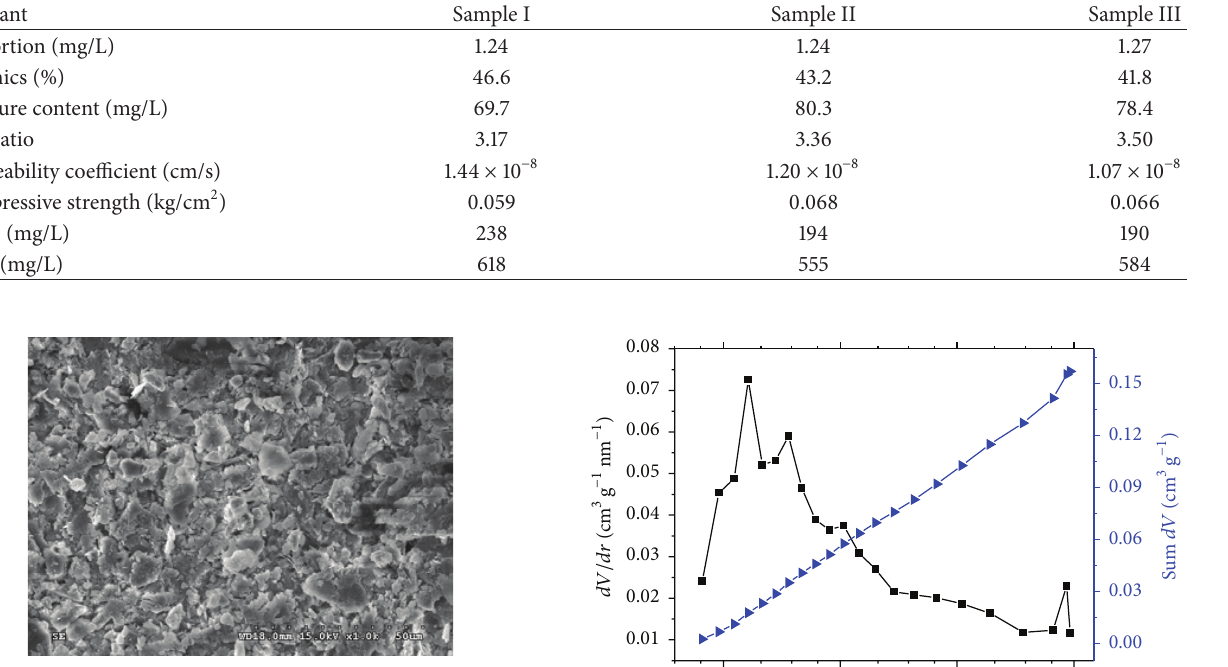
Table 1: The physical properties of samples.